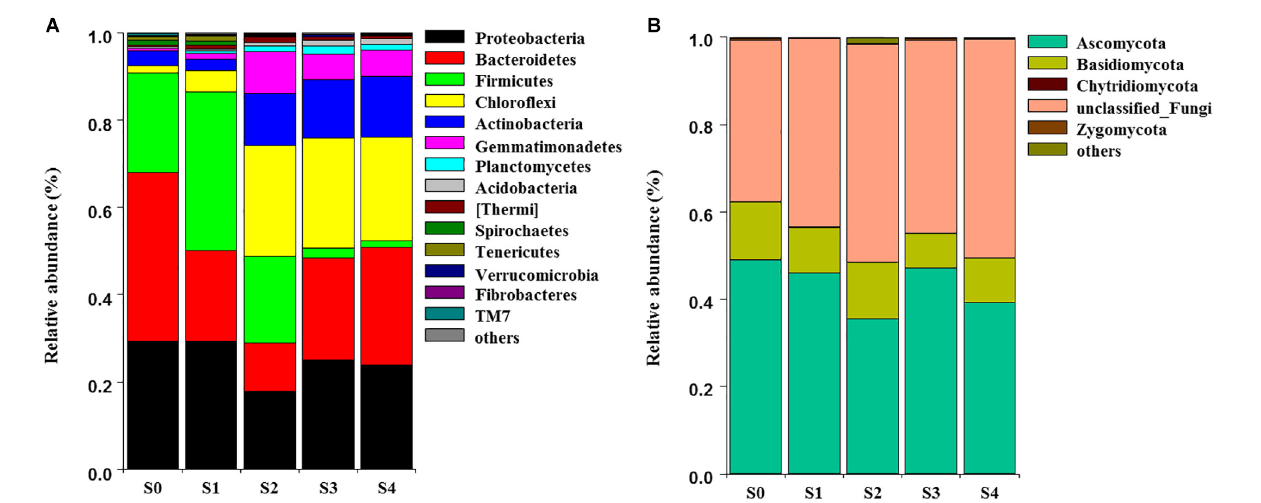
FIGURE 3 | Dynamic changes of community composition of bacterial (A) and fungal (B) at the phylum level. The relative abundance of phylum was above 0.1% in at least one sample. Phyla with relative abundance less than 0.1% were defined as others.